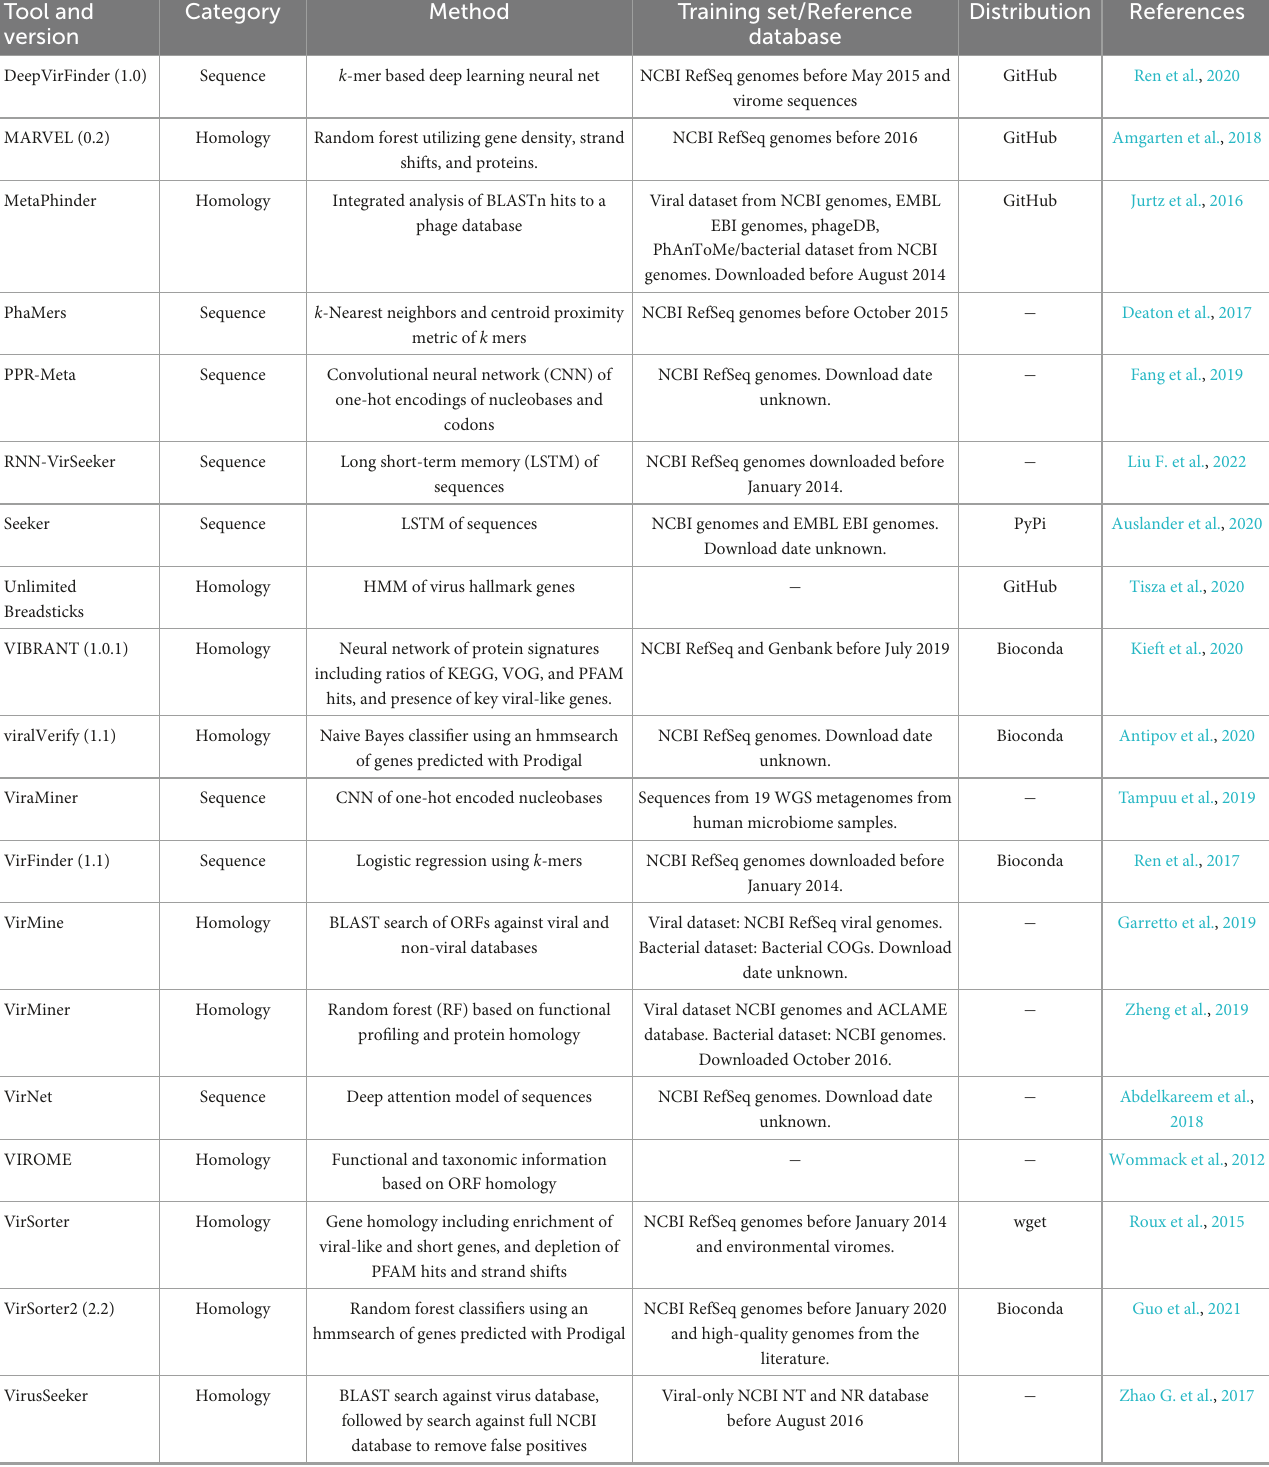
TABLE 1 Overview of published metagenomic phage detection